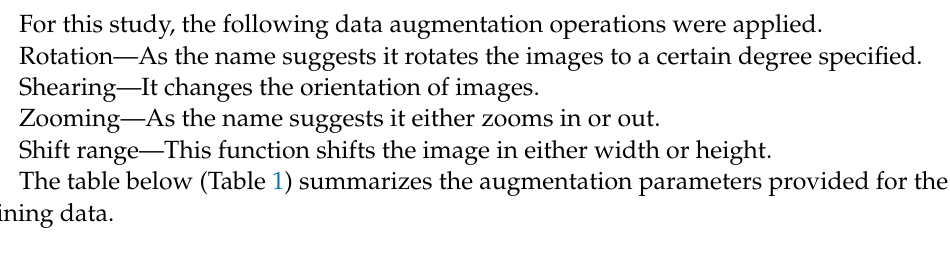
Figure 3. These images show augmented images extracted from a patient with a BAC of grade 1.